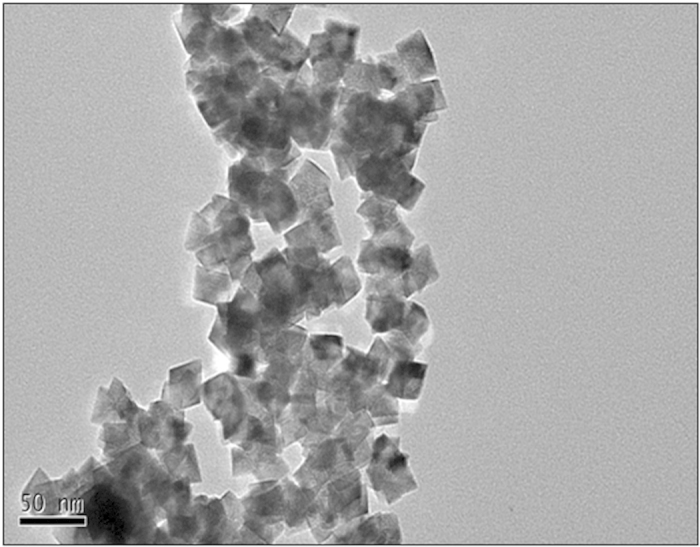
TEM image of CeO2 nanoparticles.